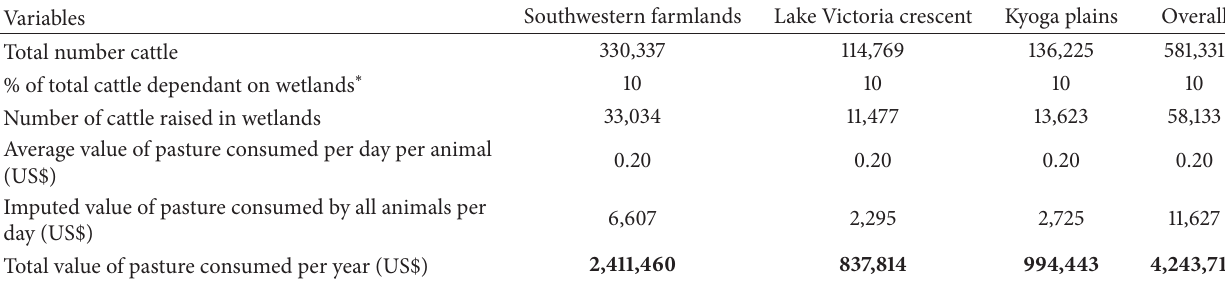
Table 6: Monetary value of wetland pastures in three agro-ecological zones in Uganda.